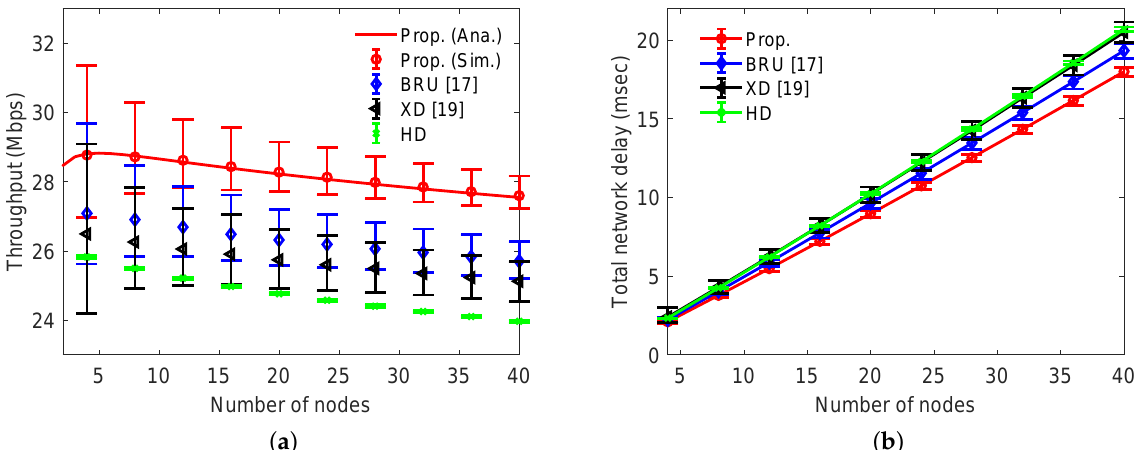
Figure 5. Overall network performance based on the number of nodes (SIC = 110 dB) for ( a ) throughput and ( b )